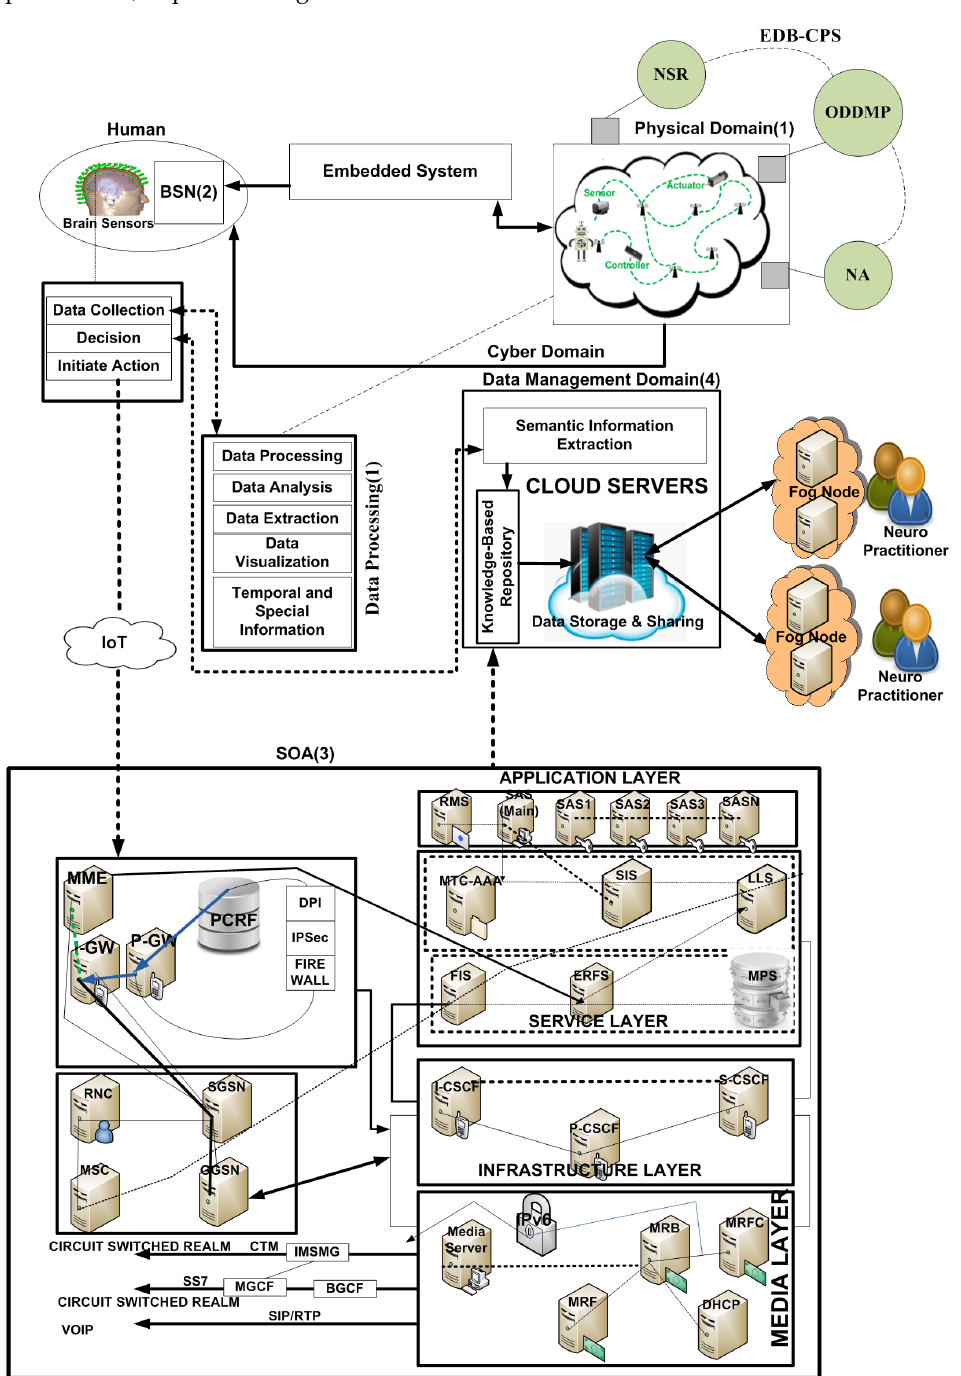
Figure 2. Proposed CPS-HBM to support efficient data